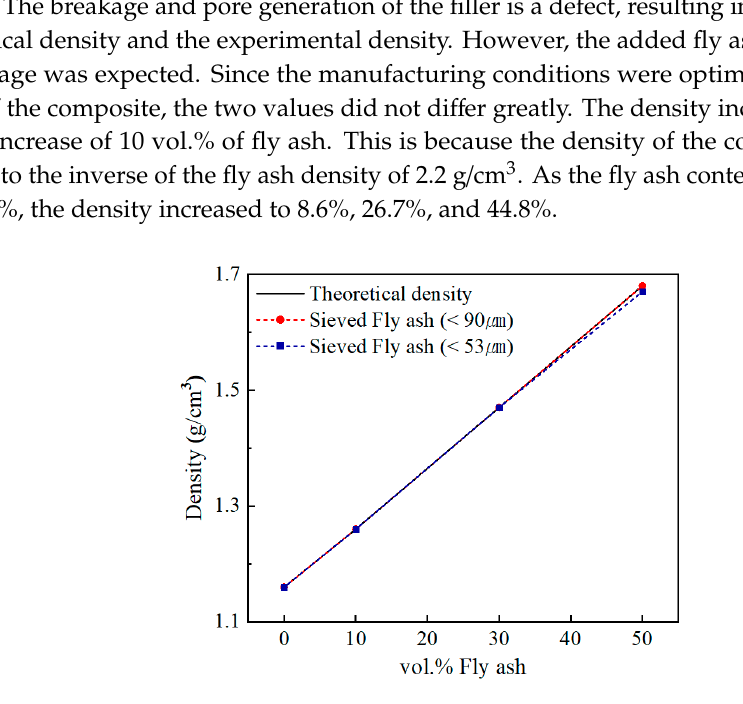
Figure 5. Density variation with fly ash content for composite containing: ( ● ) less than 90 μ m, ( ■ ) less than 53 μ m .